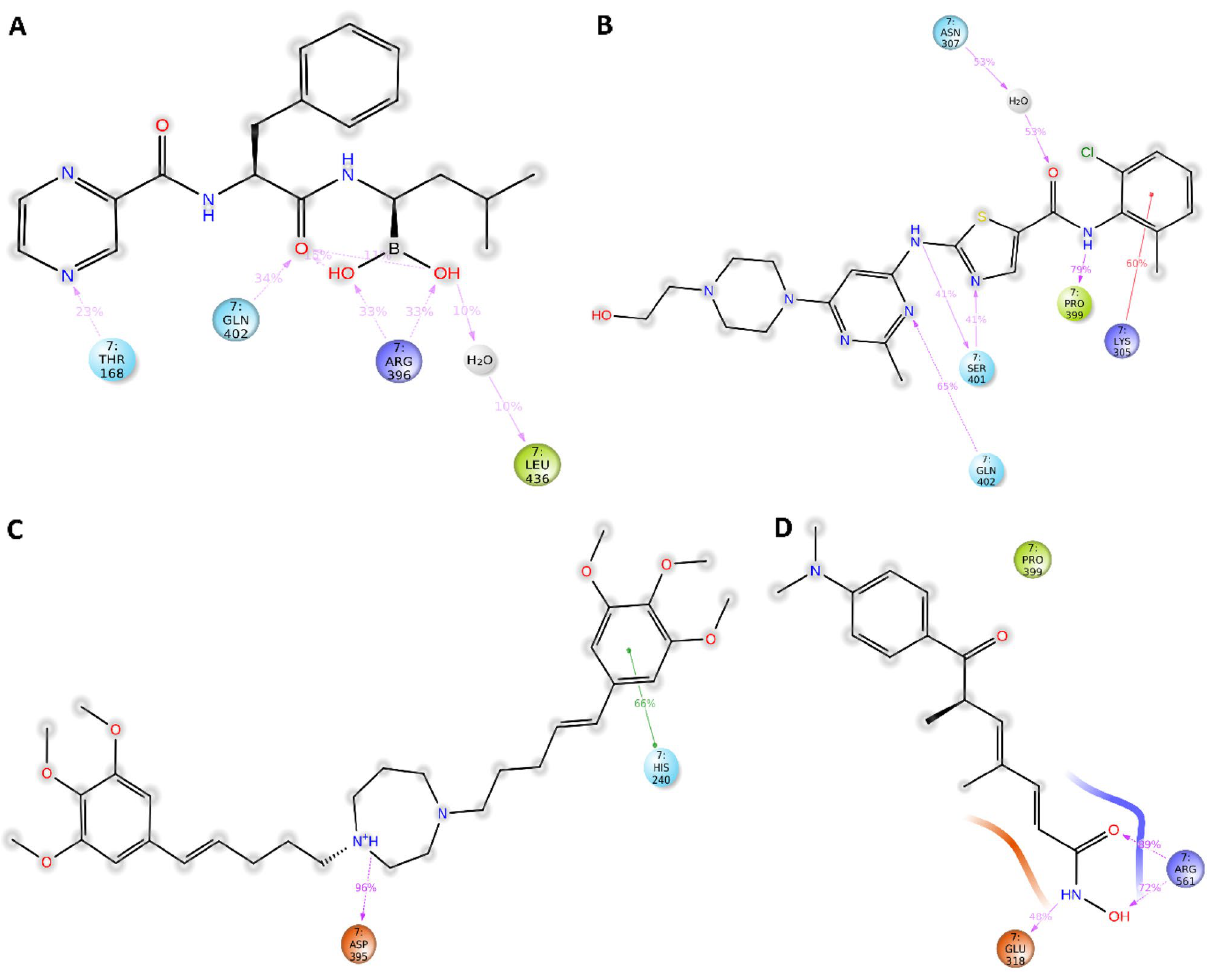
Figure 10. Graph exhibiting the information about the ligand–protein contacts, after 500 ns simulation. In this place, ( A ) CID_387447, ( B ) CID_3062316, ( C ) CID_9874191, and ( D ) CID_444732 (control).